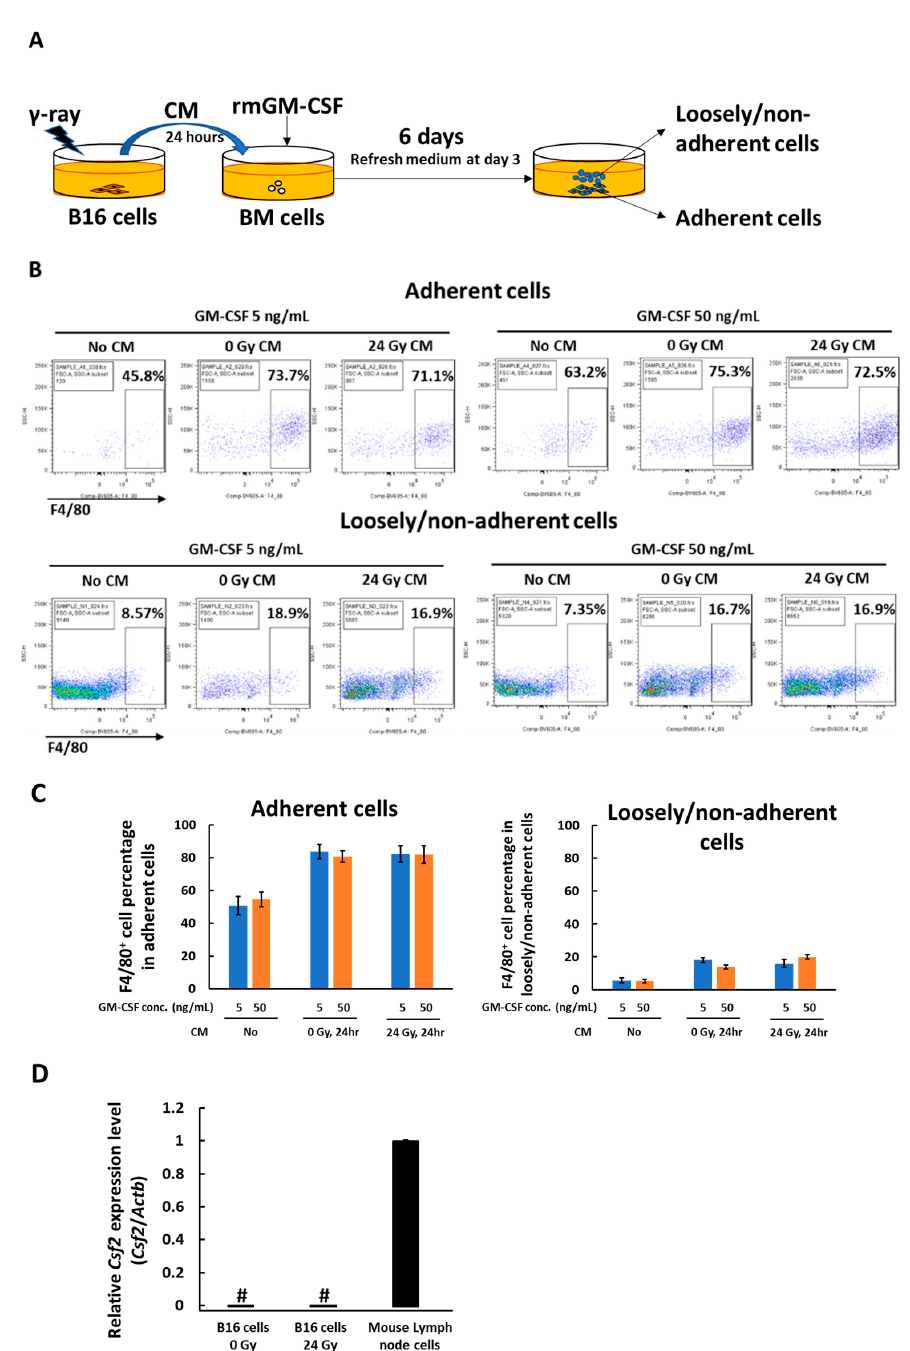
Figure 1. In vitro culture system for bone marrow cell differentiation in the presence or absence of GM-CSF and CM from non-irradiated or 24 Gy γ -irradiated B16 cells. ( A ) schema of the in vitro culture. ( B ) The adherent and loosely/non-adherent cells were recovered after culture for 6 days in the presence or absence of GM-CSF plus CM obtained from non-irradiated or 24 h after 24 Gy γ -irradiated B16 cells, stained with a mouse macrophage marker F4/80 antibody and analyzed by flow cytometry. ( C ) F4/80 positive cell percentages in adherent cells and loosely/non-adherent cells. ( D ) Real-time PCR analysis of Csf2 gene expression in B16 cells 24 h after γ -irradiation. #, undetected; Mean ± SE, n = 3.